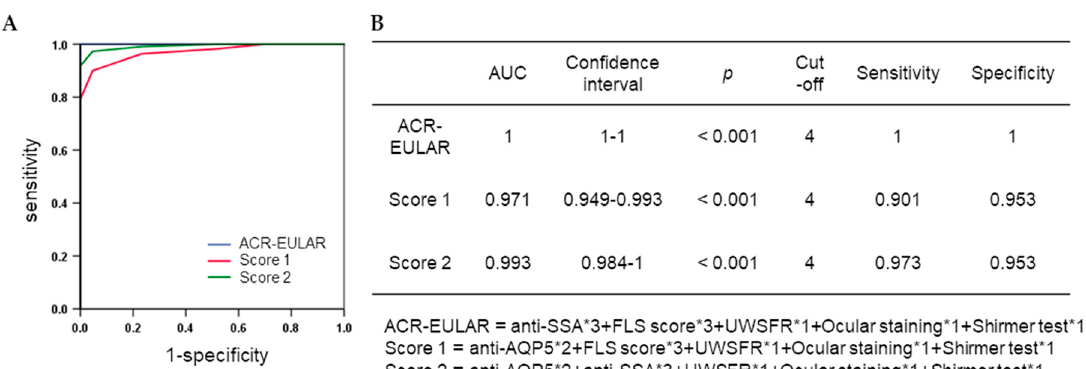
Figure 3. Diagnostic performance of anti-AQP5_E IgG when it replaced either anti-SSA positivity or the FLS score in the 2016 ACR-EULAR criteria. ( A ) ROC curves ( B ) AUC, sensitivity, specificity, and the equations used to obtain each SS criteria in the ROC curves. Table 5. Bivariate analysis exploring the presence of anti-AQP5_E1 IgG by adverse prognostic markers in 111 SS samples.